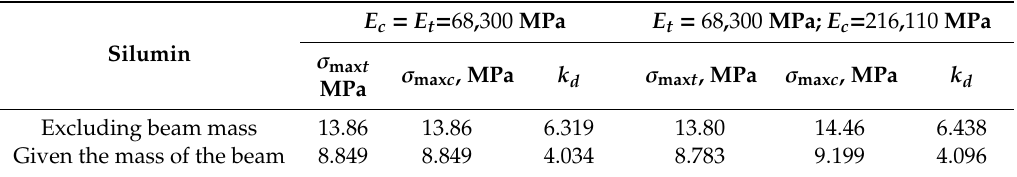
Table 5. Maximum normal stresses ( σ max t , σ max c ) and dynamic coe ffi cient ( k d ) of a silumin beam.